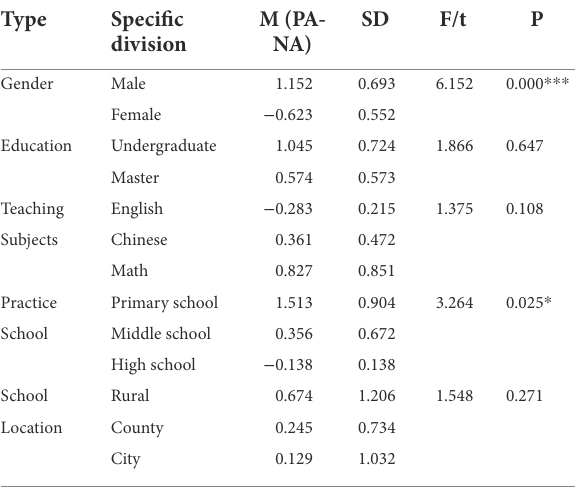
TABLE 4 Results of the test of variability of the positive